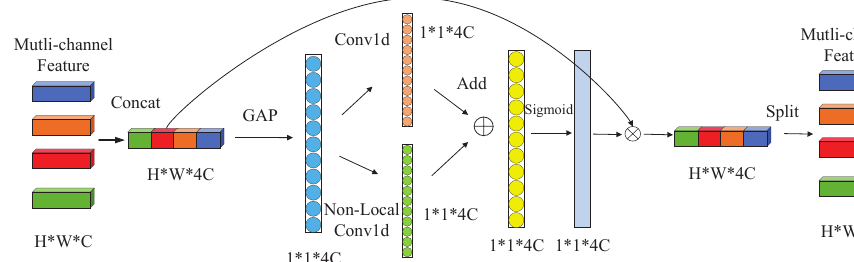
Figure 4. Schematic diagram of NLECA module.